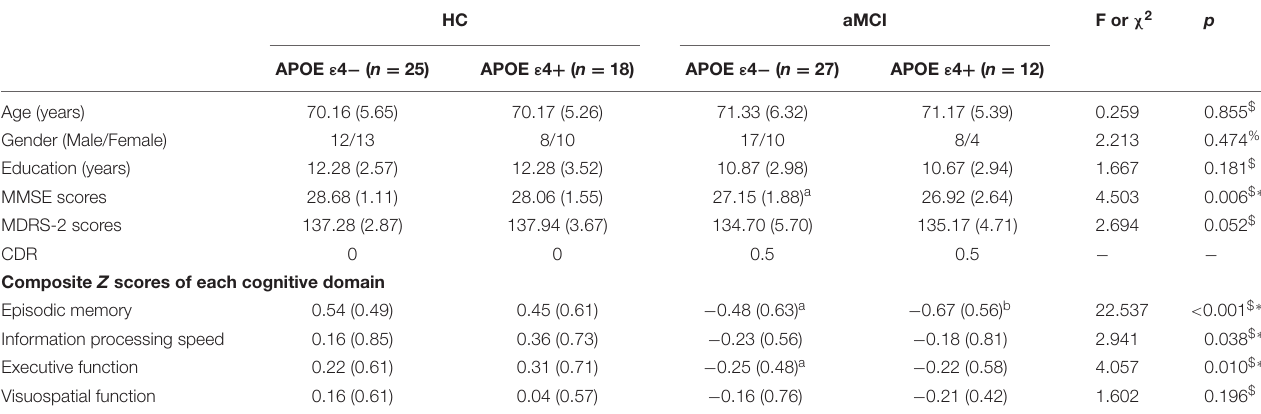
TABLE 1 | Demographic data and neuropsychological performance for all